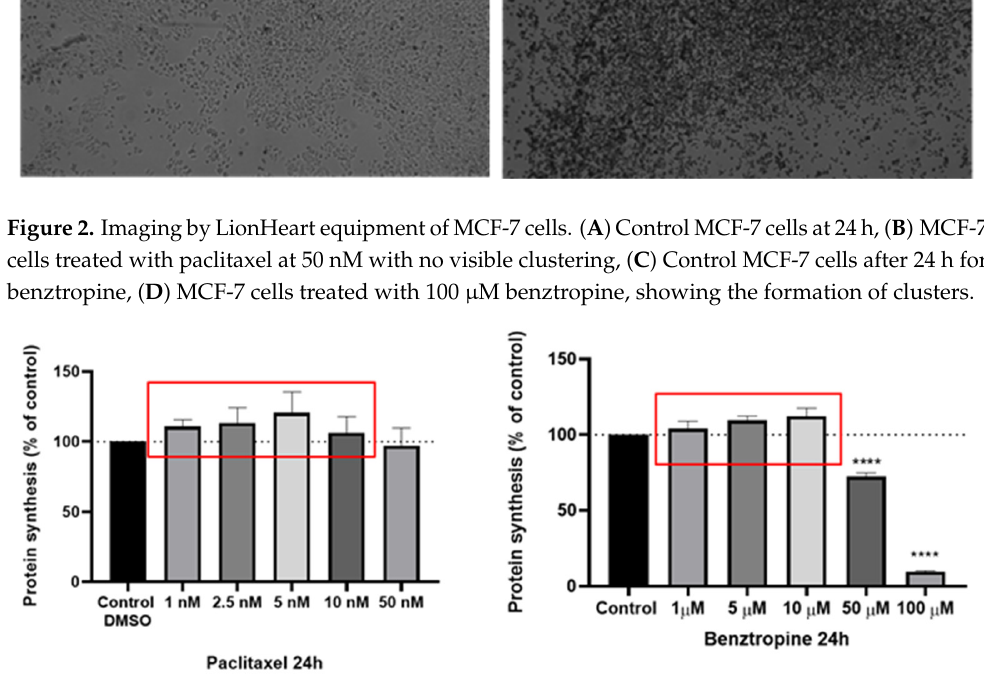
Figure 2. Imaging by LionHeart equipment of MCF-7 cells. ( A ) Control MCF-7 cells at 24 h, ( B ) MCF- 7 cells treated with paclitaxel at 50 nM with no visible clustering, ( C ) Control MCF-7 cells after 24 h for benztropine, ( D ) MCF-7 cells treated with 100 µM benztropine, showing the formation of clus- ters.